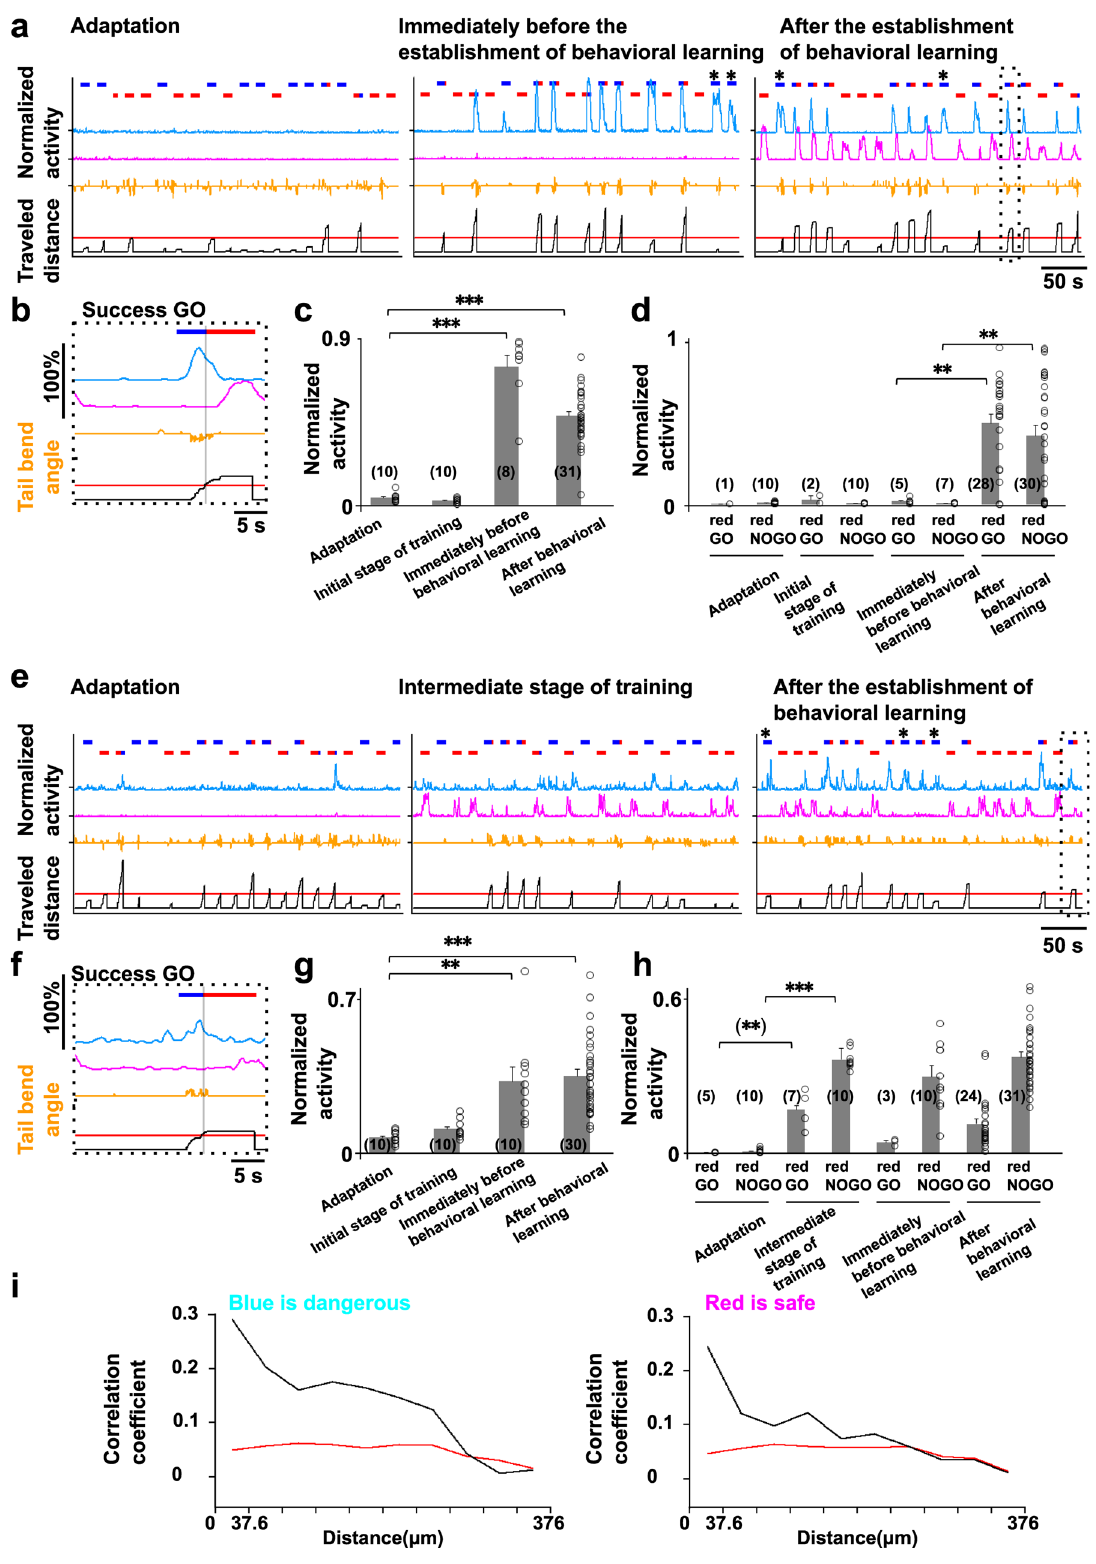
is safe). No activity of this ensemble was observed in the adaptation and initial stages of training (Fig. 4a, left panel and Supplementary Figs. 5 – 7a), suggesting that the ensemble did not encode the simple perception of red color. The activity of this ensemble was observed whenever the fi sh perceived red color, which was not paired with shock, during repeated trials (Fig.